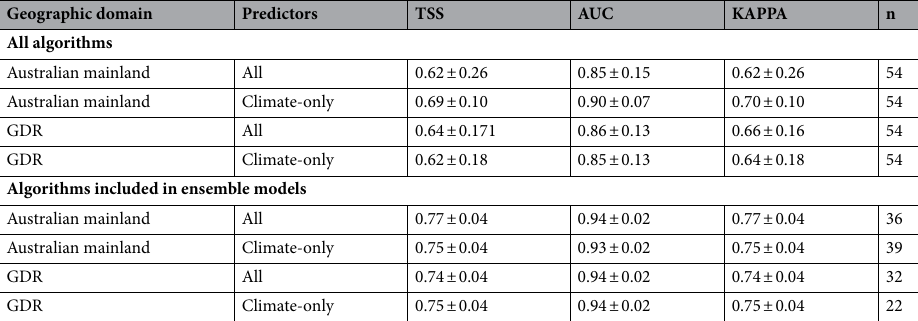
Table 1. Model performance test scores (mean ± SD) for each domain, including all variables (‘all’) or including only bioclimatic variables (‘climate-only’). Included are the scores for models with all algorithms and ensemble models (including algorithms above the threshold). n is the product of the number of algorithms and the number of model runs per